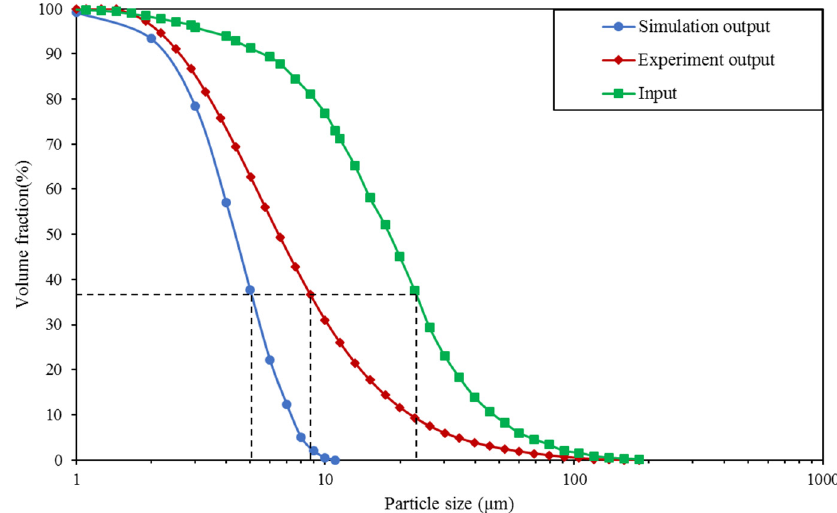
Figure 8. Cumulative size distribution of dust particles escaping from the dust suppression device when the inlet wind velocity was 20 m/s under the Rosine–Rammler mathematical distribution. (The particle size constant is the particle size when the cumulative volume fraction is 36.8%).